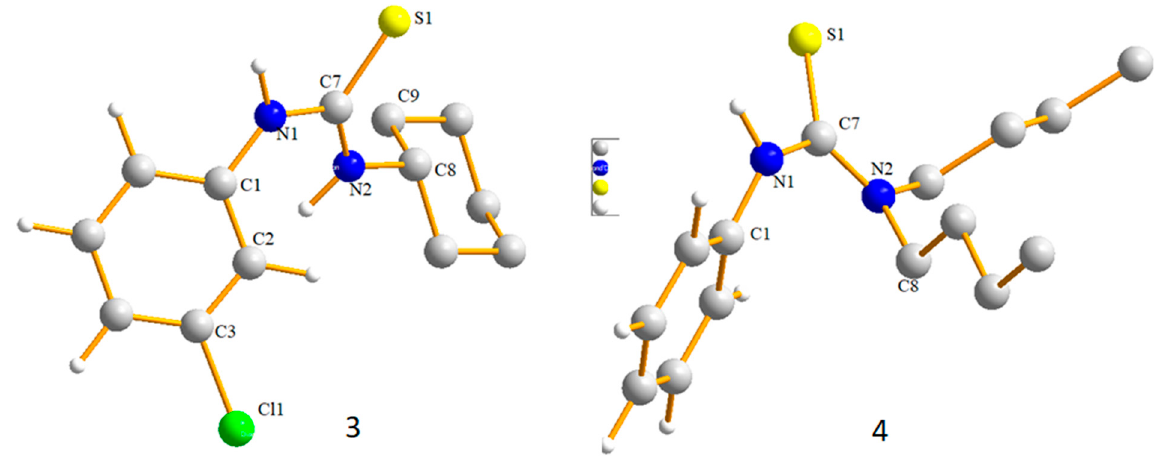
Figure 5. Optimized structures of compounds 3 and 4 , selected hydrogen atoms are omitted.